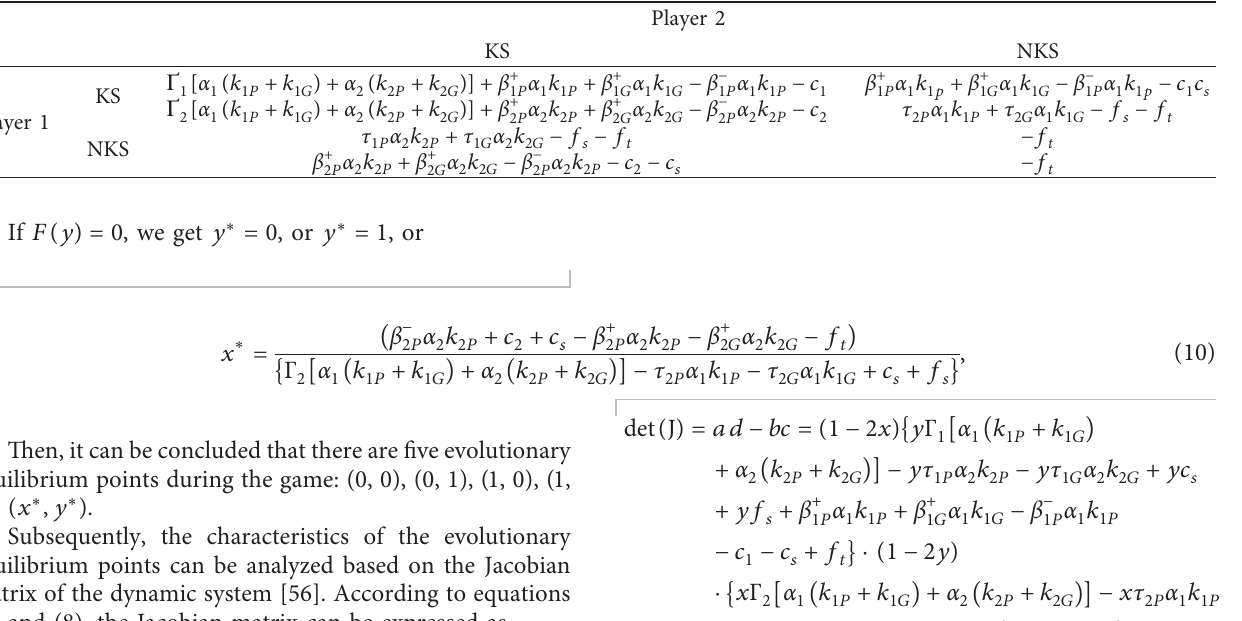
Table 2: Pay-off function